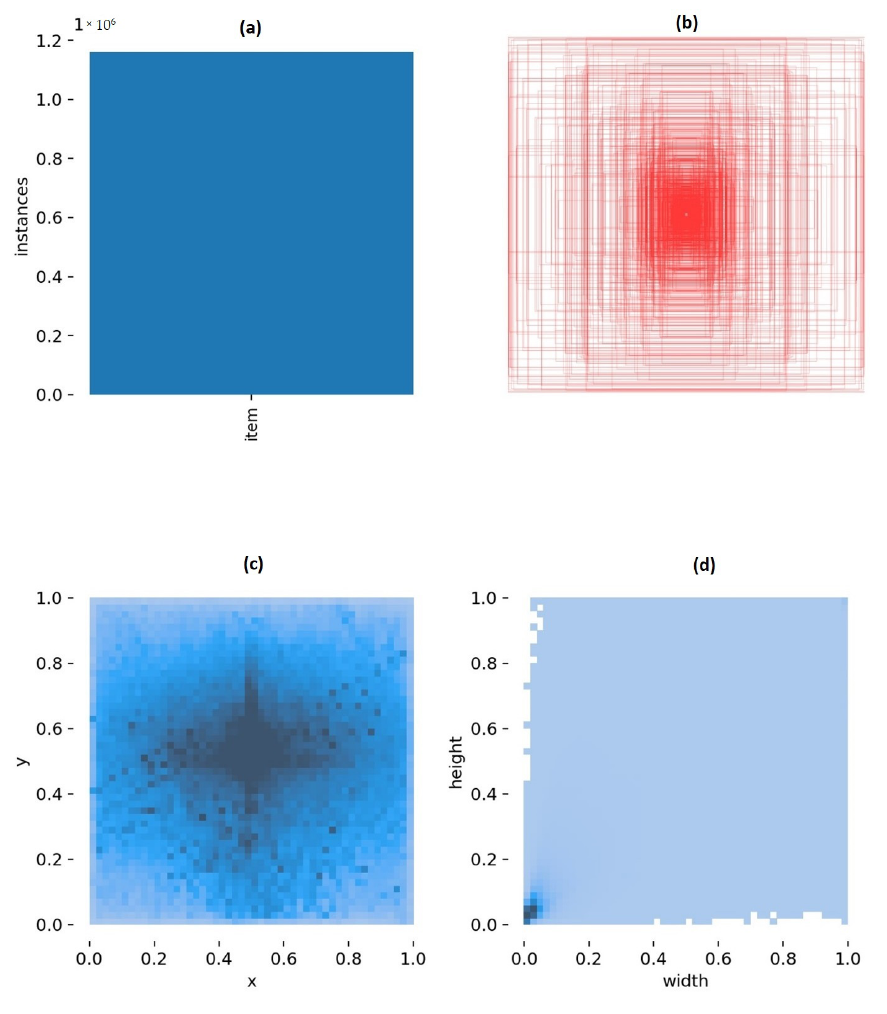
Figure 20. Model trained on SEAGULL and COCO—( a ) number of training items in the dataset, ( b ) anchor boxes used for the final bounding boxes, i.e., the detections, ( c ) frequency of the central positions of the objects of the dataset, ( d ) size of the bounding boxes as a percentage of the images’ width and height for the SEAGULL- and SEAGULL+COCO-trained models, respectively.